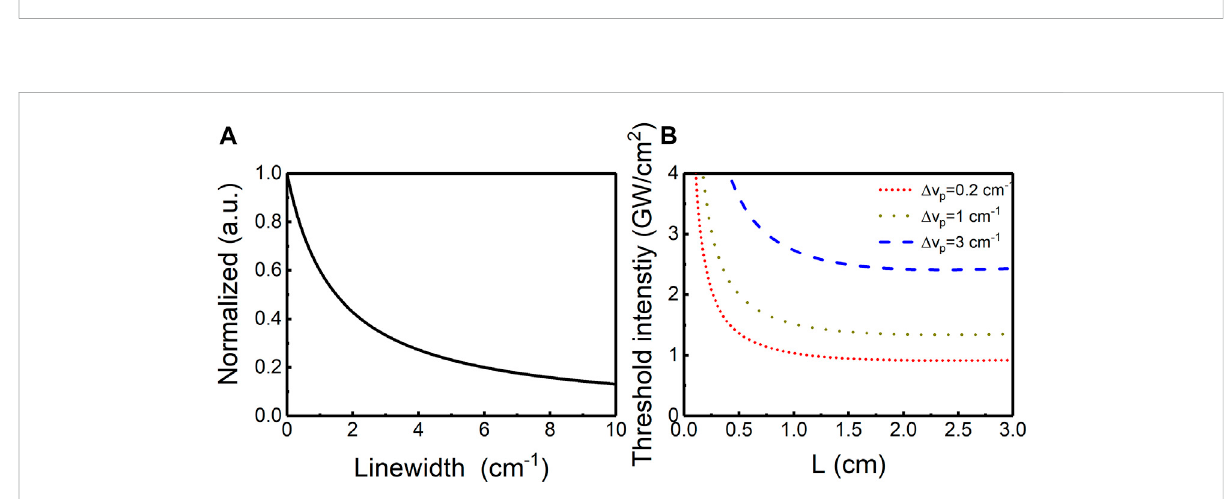
Figure 3C. The different optimal lengths of the diamond correspond to different T for the maximum output